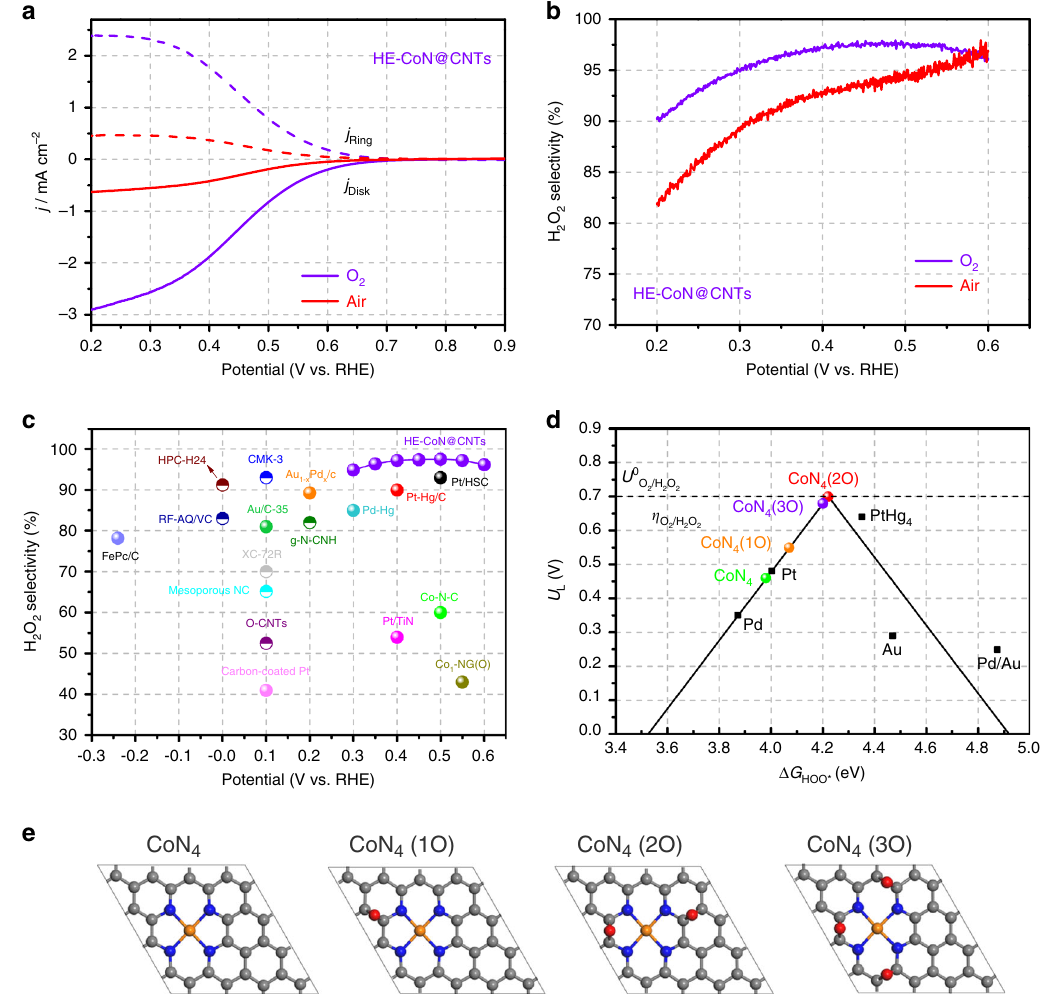
Fig. 4 ORR activities of HE-CoN@CNTs and DFT results of different types of epoxy-modi fi ed Co – N 4 sites. a RRDE measurements of HE-CoN@CNTs for ORR in 0.1 M HClO 4 solution purged with O 2 and air. b Calculated H 2 O 2 selectivity on HE-CoN@CNTs in O 2 - and air-saturated 0.1 M HClO 4 based on the RRDE measurements. c H 2 O 2 selectivity on HE-CoN@CNTs and other recently reported catalysts (Supplementary Table 4) in acidic media. d Calculated Sabatier volcano plot for the 2-electron ORR to H 2 O 2 for bare CoN 4 moiety and CoN 4 moieties with different epoxy oxygen coverages obtained from DFT simulations. The U L is plotted as a function of Δ G HOO (cid:1) . The black solid lines represent the theoretical Sabatier volcano 22 . The black squares are the data adapted from ref. 22 . e The optimized geometry structures of bare CoN 4 moiety and CoN 4 moieties with different epoxy oxygen coverages, which were chosen to calculate the ORR activities in this work. Here, CoN 4 indicates bare CoN 4 moiety. CoN 4 (1O), CoN 4 (2O), and CoN 4 (3O) indicate CoN 4 moieties with 1, 2 or 3 epoxy oxygen, respectively. The gray, blue, orange and red balls represent C, N, Co and O atoms,